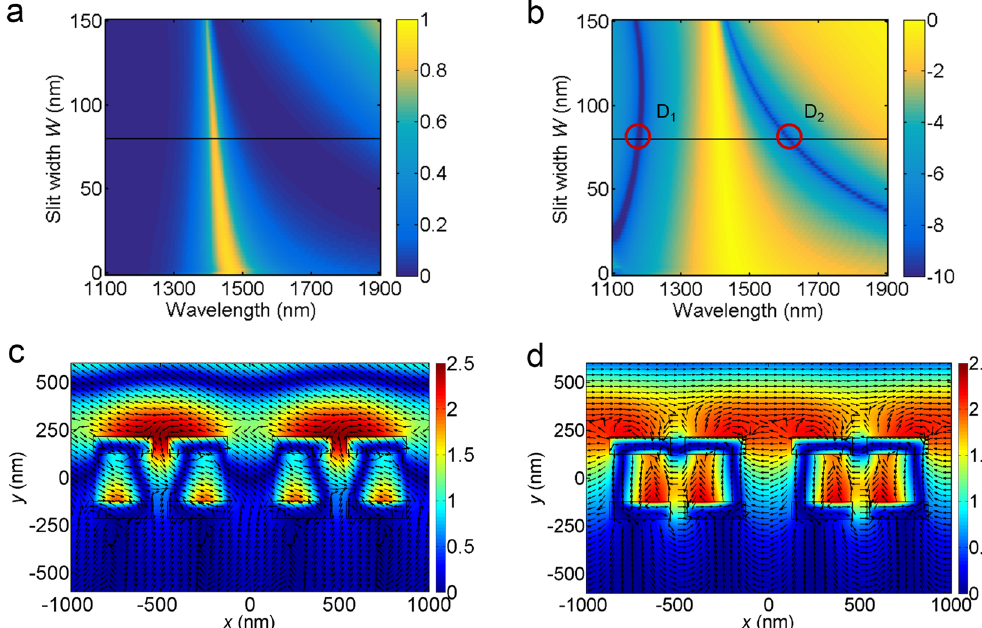
Figure 6. Calculated transmission in ( a ) linear color map ( b ) logarithmic color map as a function of slit width W and wavelength. The red circles D 1 and D 2 correspond to two transmission minima with slit width W = 80 nm. Calculated magnetic field intensity | H z | (color map) and electric displacement (arrow map) for ( c ) D 1 and (d) D 2